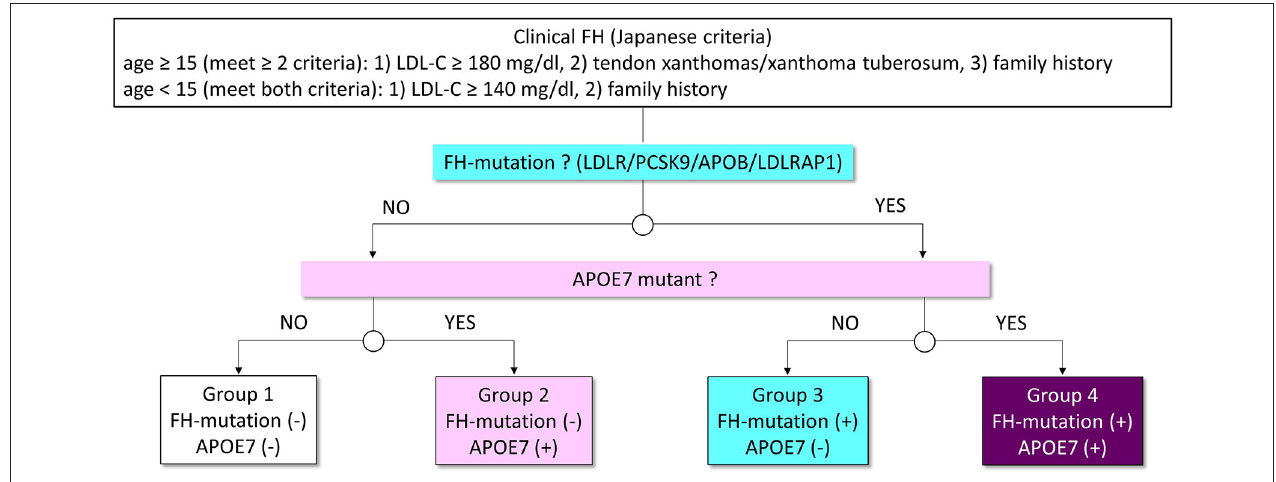
FIGURE 1 | Analytic scheme in this study. Patients with FH were classified into four groups based on the status of FH mutation and APOE7 mutant (Groups 1–4). White indicates patients without mutations. Pink indicates patients with APOE7 mutant. Light blue indicates patients with a mutation in FH genes. Purple indicates patients with a mutation in FH genes and APOE7 mutant.